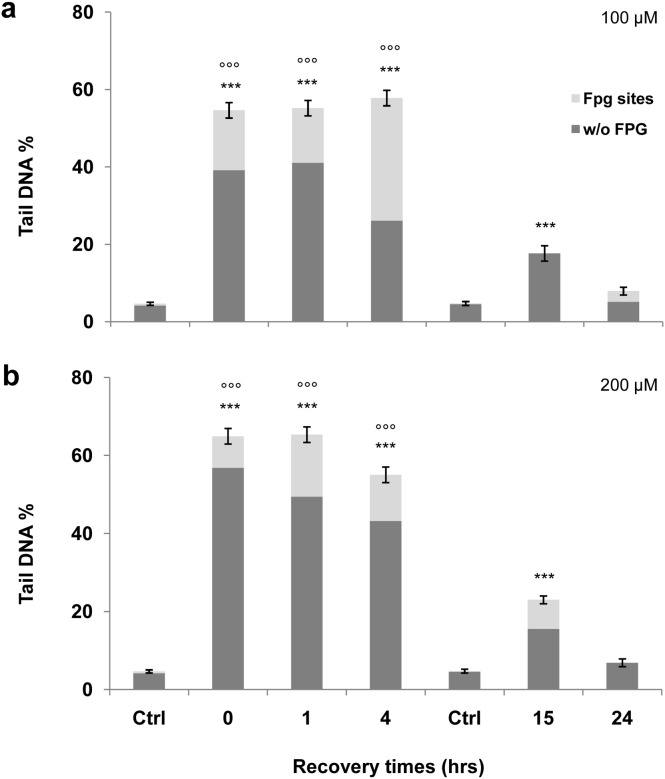
Standard and FPG-modified alkaline comet assay.Standard and FPG-modified versions of the comet assay have been used to evaluate the fold increase in genomic damage induced by hydrogen peroxide with respect to the control value. The net cleavage sites generated by FPG activity were calculated subtracting the value of total DNA damage yielded by the samples not treated with the enzyme from the DNA damage value obtained from samples treated with the enzyme. The value of this subtraction is shown in the graph as a light grey portion labelled ‘‘FPG sites.’’ To assess any changes in Tail DNA values, we analysed control cells immediately (time 0) and after 15 hrs treatment. All values are normalised to the control values. A significant increase (p<0.001) is observed in the percentage of DNA damage immediately after treatment (time 0). DNA damage increases in a dose dependent manner after 1 hr treatment. We observed a time-dependent decrease of genomic damage to the control value 15 and 24 hrs after treatment. Error bars denote the standard error. (a) DNA damage induction by 100 µM H2O2. (b) DNA damage induction by 200 µM H2O2. ***p<0.001; **p<0.01; *p<0.05. Treated cells plus FPG versus controls plus FPG by Mann–Whitney U test. °°°p<0.001; °°p<0.01; °p<0.05 Treated cells plus FPG versus cells of the same experimental point without FPG by Mann–Whitney U test.